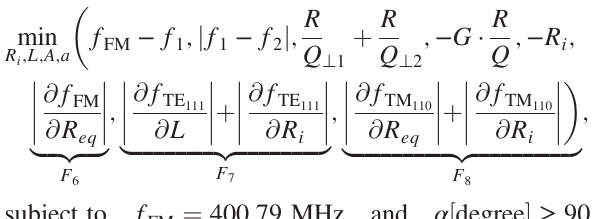
FIG. 8. Main sensitivities. For a point ð R i ; L; A; B; a; b Þ inside the intervals from Table III, f is tuned to 400.79 MHz using FM R ∈ ½ 345 ; 355 (cid:2) . The polynomial degree is p ¼ 2 , so the eq ½ mm (cid:2) size of the sample is 140 [cf. Table